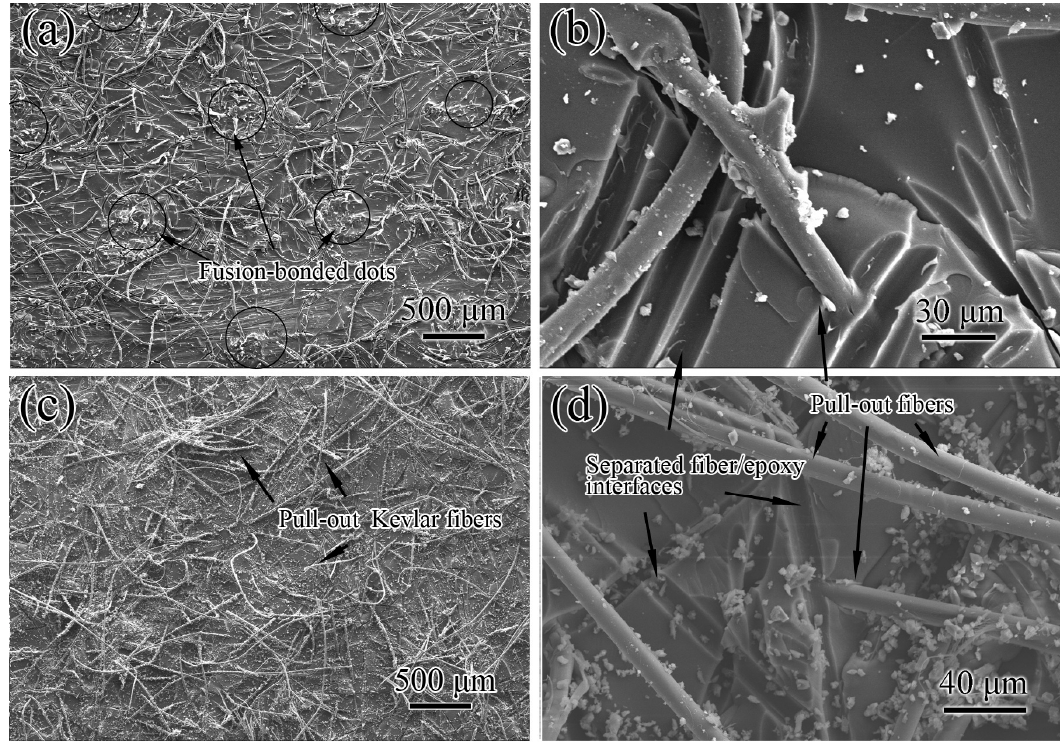
Figure 5. SEM images of the Mode I fracture surfaces of interleaved composites. ( a ) and ( b ) are NVIC, and ( c ) and ( d ) are KVIC.